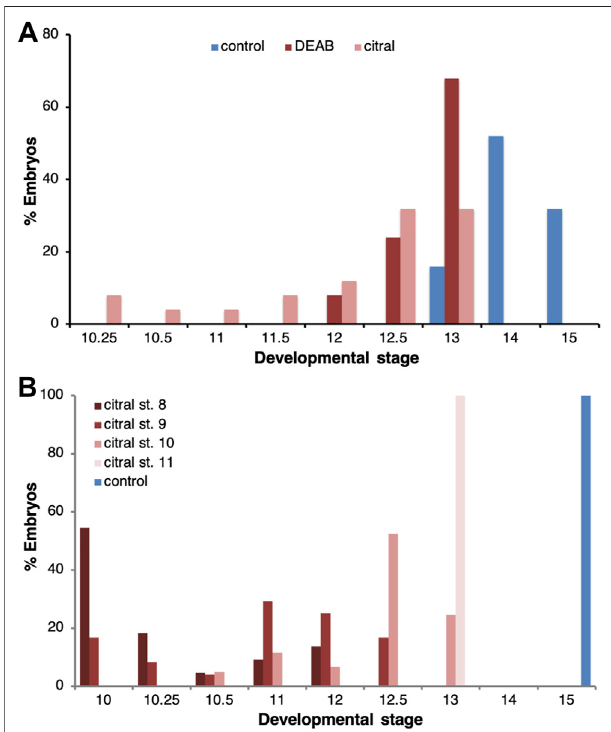
FIGURE 1 | Delayed progression through gastrulation as a result of RA biosynthesis inhibition. (A) The progression of embryos through gastrulation treated with DEAB (300 μ M; n = 38) or citral (70 μ M; n = 39) to inhibit RA biosynthesis. When the majority of control embryos reached early neurula (st. 14/15; n = 38), the stage distribution of the treated samples was determined. The percentage of embryos at each stage in each treatment is shown. (B) The temporal sensitivity window for the delay in gastrulation induced by inhibition of RA biosynthesis was studied by initiating the citral treatment at different developmental stages (8, n = 22; 9, n = 24; 10, n = 61; 11, n = 24). When control embryos reached early neurula (st. 15), the stage distribution of the treated samples was determined. The percentage of embryos at each stage in each treatment is shown.